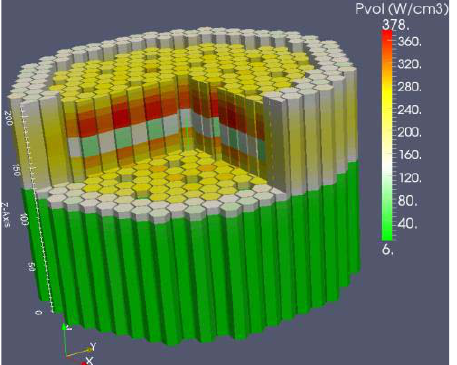
Figure 4 : Intern fuel averaged temperatures – Nominal State – CATHARE3/GERMINAL